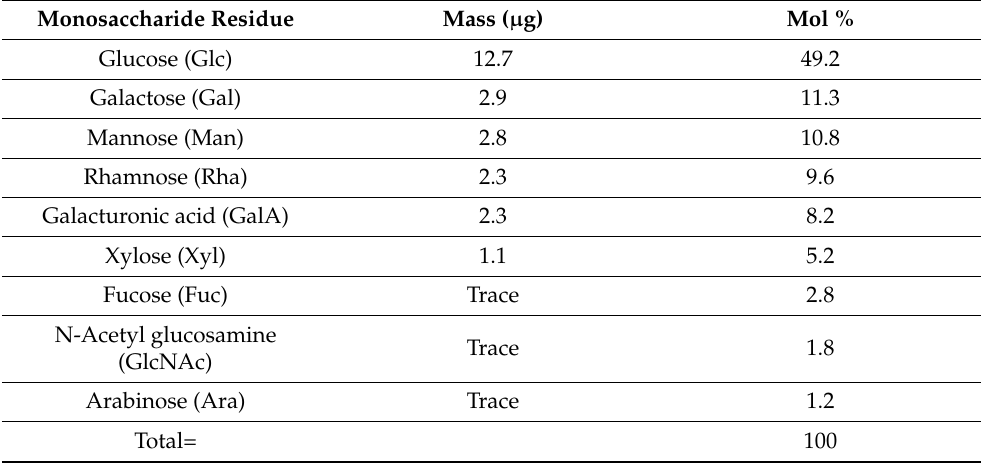
Figure 5. FTIR spectrum of IMPP-Rb. Table 1. Monosaccharide composition of purified immunomodulatory polysaccharides from R. badius (IMPP-Rb).